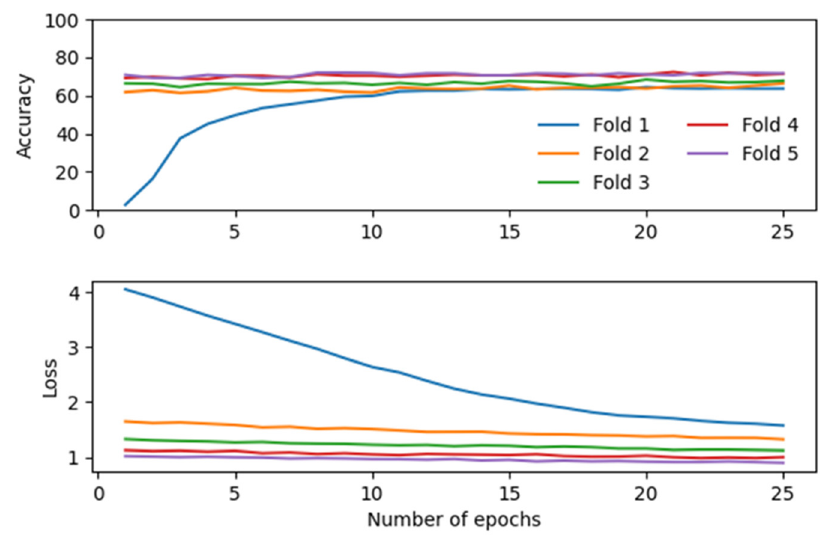
Figure 6. Accuracy and loss of the model with one hidden layer and 60 nodes on the training set.